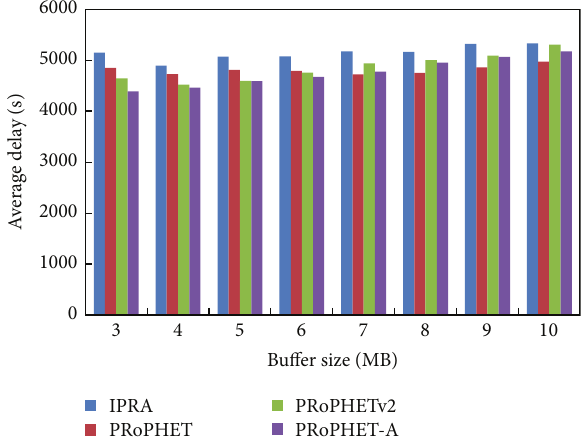
Figure 10: Average delivery rate (ADR) versus message lifetime.